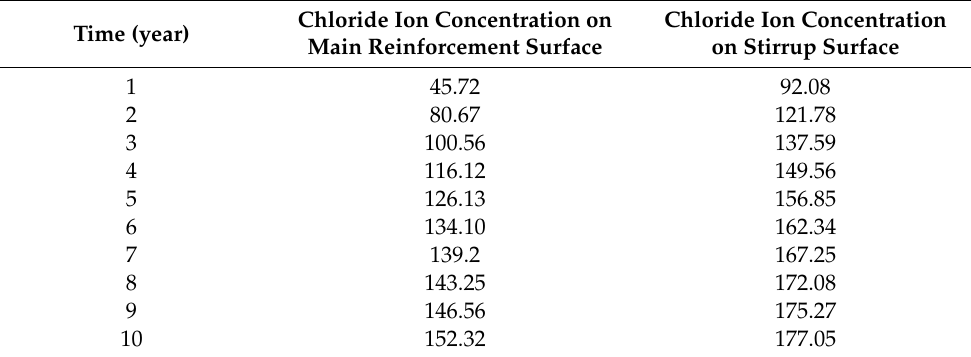
Table 2. Surface concentration values of